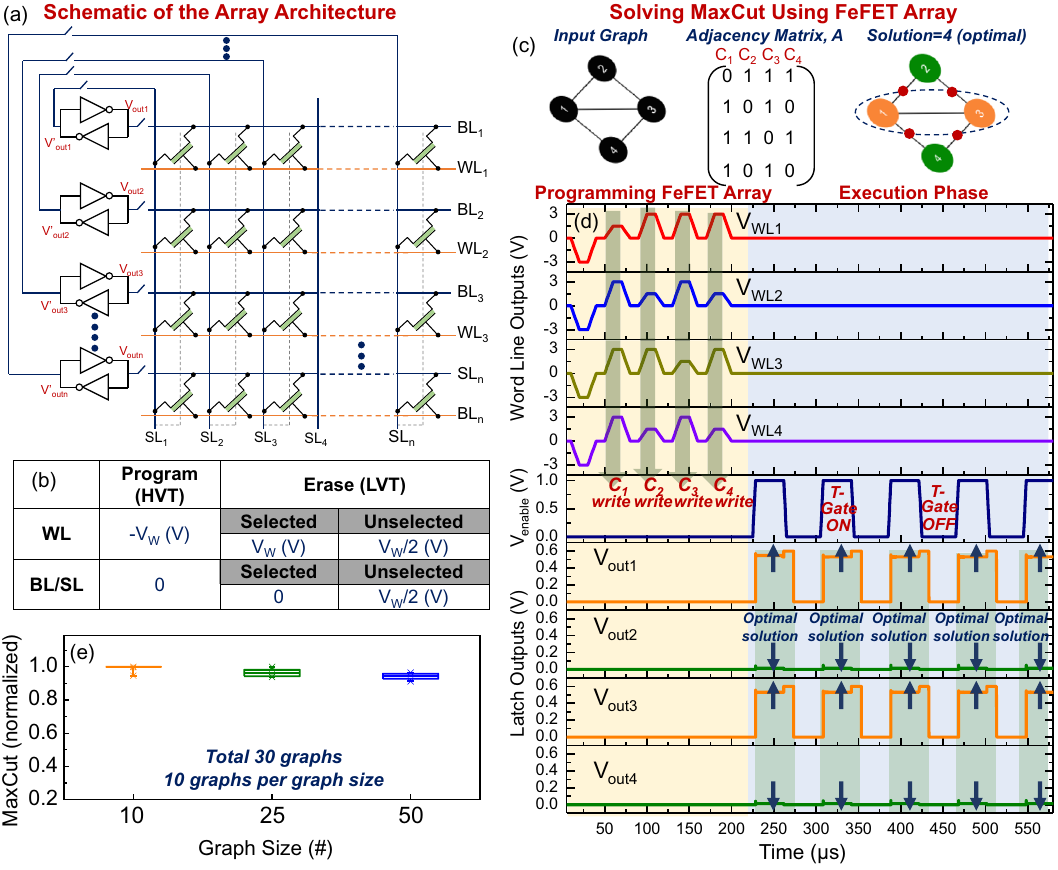
Figure 5. CMOS Latch-based Ising Machine with FeFET-based Coupling. ( a ) Schematic of the FeFET array used to implement the coupling network and its interfacing with the CMOS-latches; negative coupling (J ij = − 1) is implemented here. ( b ) Half select V W/ 2 write scheme that is used to program the FeFET array. ( c ) A representative 4 node graph problem. ( d ) Time domain output of the write voltages and latch outputs for solving the representative problem in ( c ). ( e ) MaxCut solutions obtained for graphs of various size up to 50 nodes. The graphs were randomly generated; 30 graphs were tested in total (10 different graph configurations per